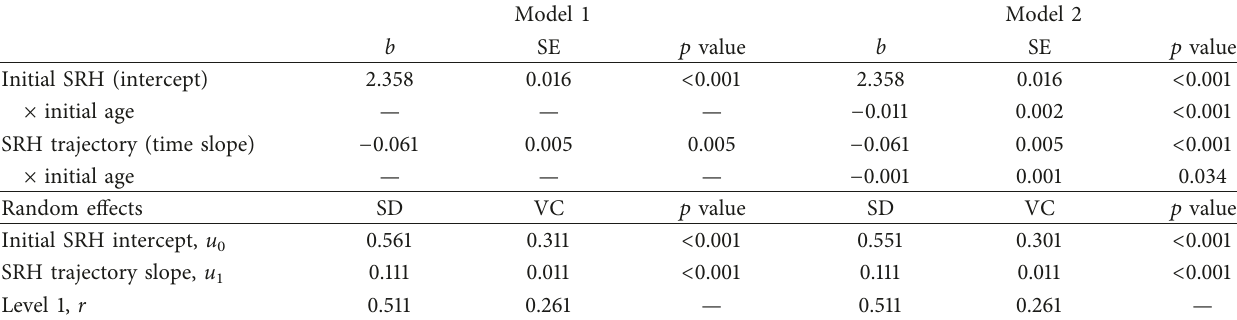
Table 3: Models 1-2: self-rated health by age and self-rated health aging trajectory.